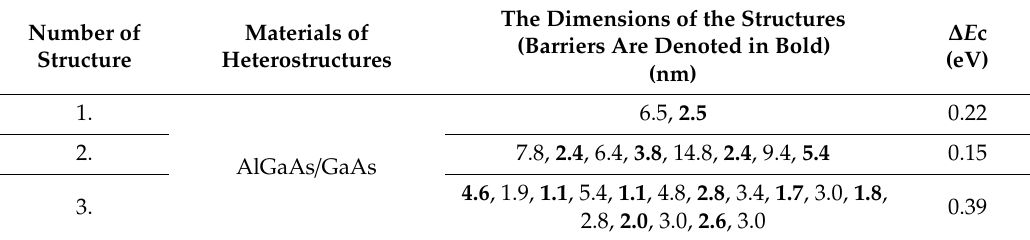
Table 1. Basic parameters of superlattice structures simulated at work. Structure no. 1 is described in [17], structure no. 2 can be found in the article [24] and structure no. 3 is presented in